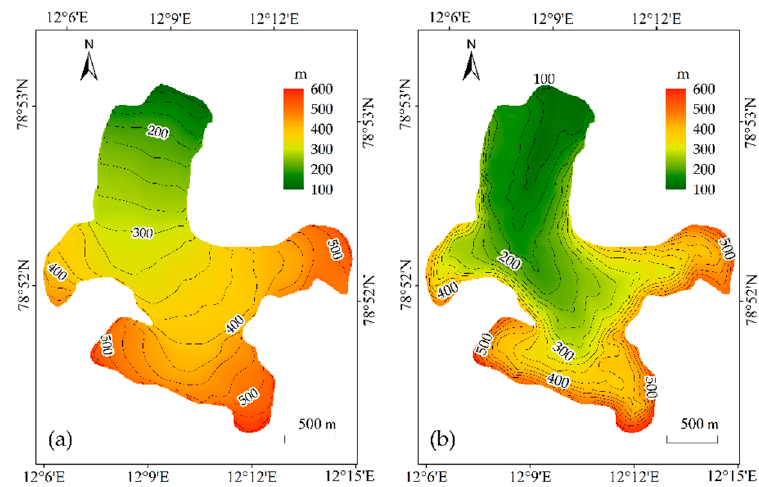
Figure 6. ( a ) Surface topography map of AL. ( b ) Bedrock topography map of AL. The contour interval is 25 m for both maps.